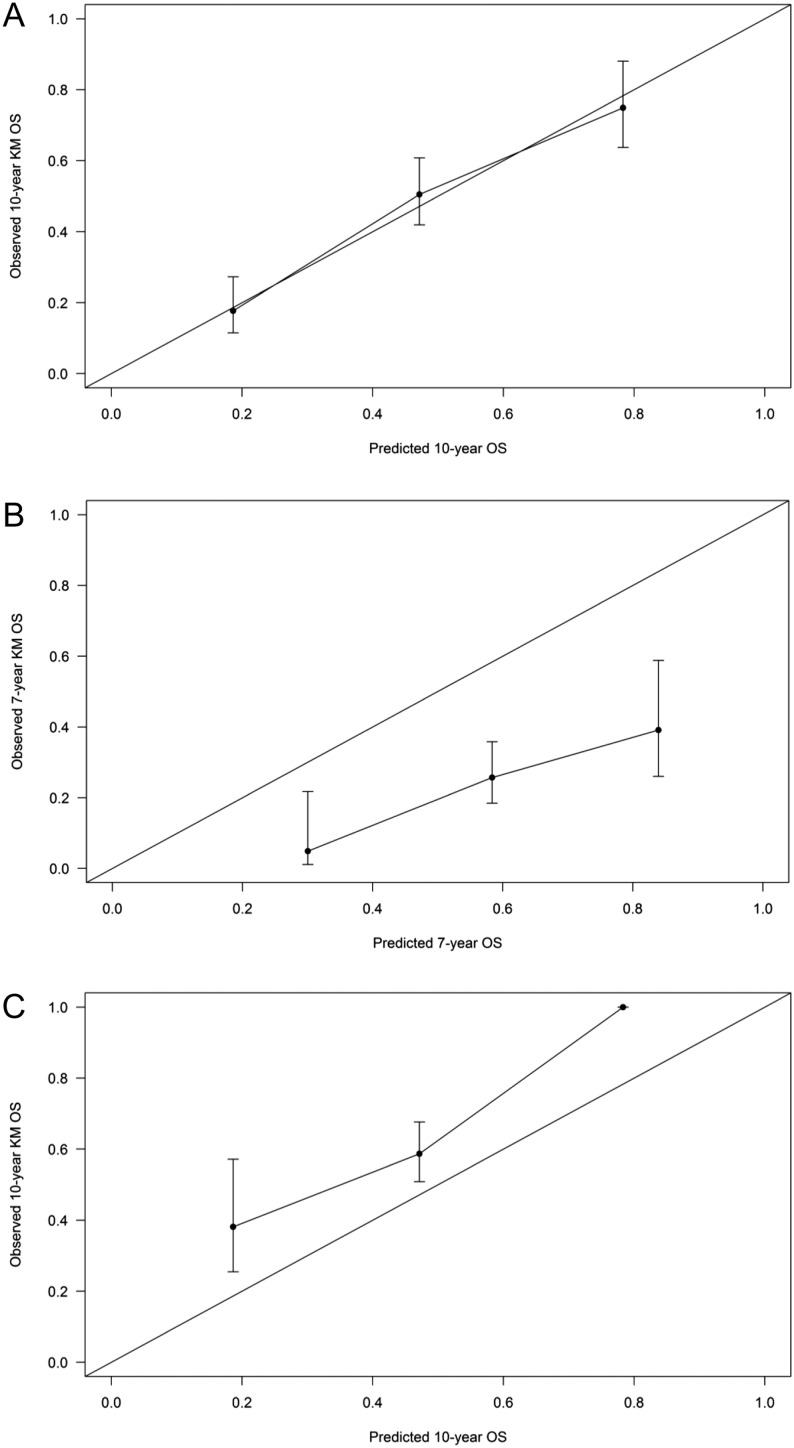
Calibration plot for internal (panel A) and external (RARECAREnet and Italian testing set patients in panel B and C, respectively) validation of the stage IV well-differentiated neuroendocrine prognostic score classification (NEP-Score). The Kaplan–Meier overall survival probability in each prognostic group was plotted (y axis) against the corresponding NEP-Score predicted probability (x axis). The error bars are the Kaplan–Meier 95% confidence intervals. The solid diagonal line is the reference line, indicating the probability of an ideal classification prognostic score (accordance between predicted and observed probabilities). OS, overall survival.